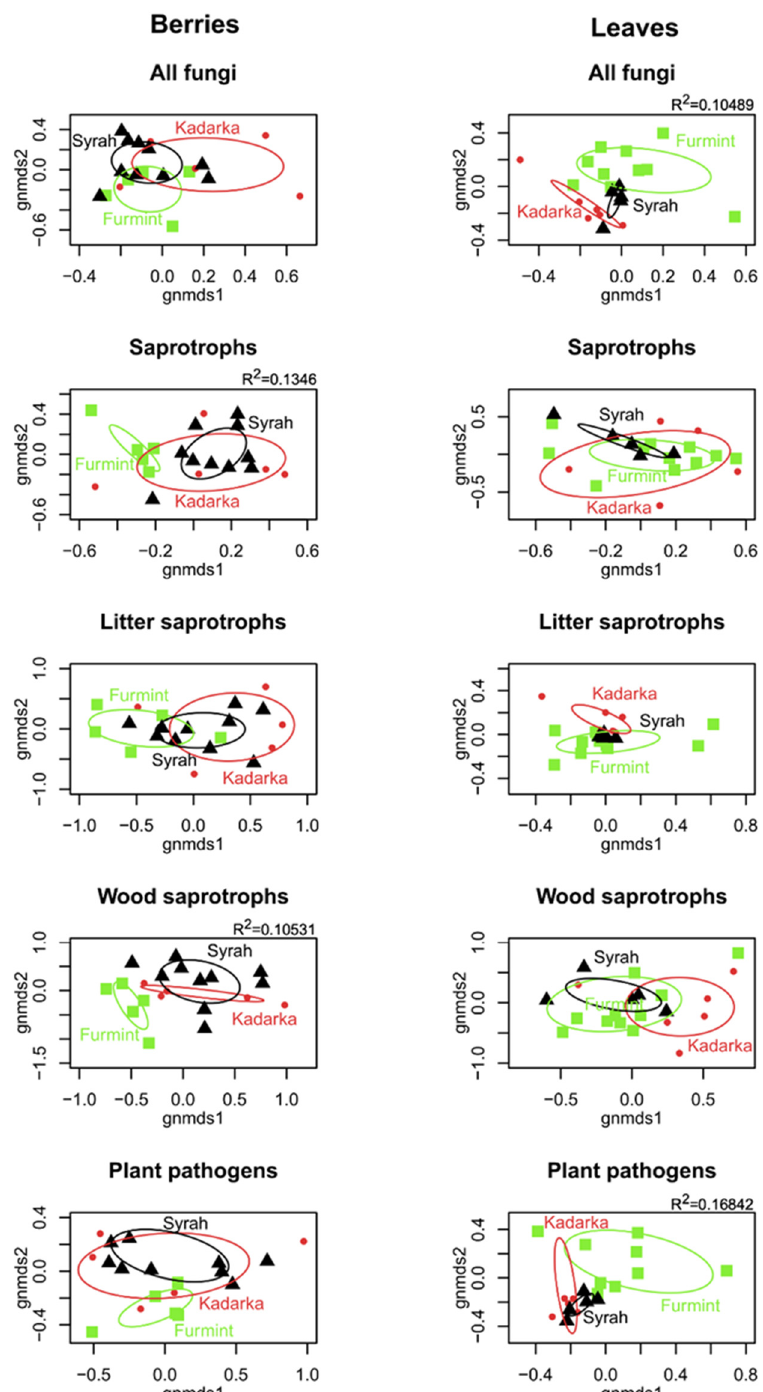
Figure 3. Non-metric multidimensional scaling (NMDS) ordination plots showing the differences in community composition of various functional groups of fungi among berry and leaf samples. The ordinations were based on a Bray–Curtis distance matrix generated from the Hellinger-transformed abundance table. Ellipses show the standard deviation of the compositional differences among samples from the same cultivar. R 2 values indicate the explained variance of compositional differences among samples explained by the cultivar, based on PerMANOVA analyses (only statistically significant results are shown).